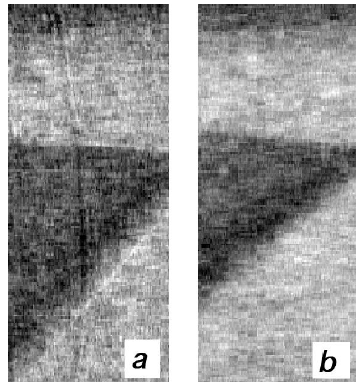
Figure 11. Blown-up region taken across the top-right corner of the plastic cylinder visible in Figure 10 (see rectangle in Figure 10b) showing how the 75 μ m aluminum wires are detected in the XPCi ( a ) but not in the attenuation-based ( b ) image. Note that in (a) the wire is still visible also behind the cylinder itself (NB here (a) is XPCi and (b) is